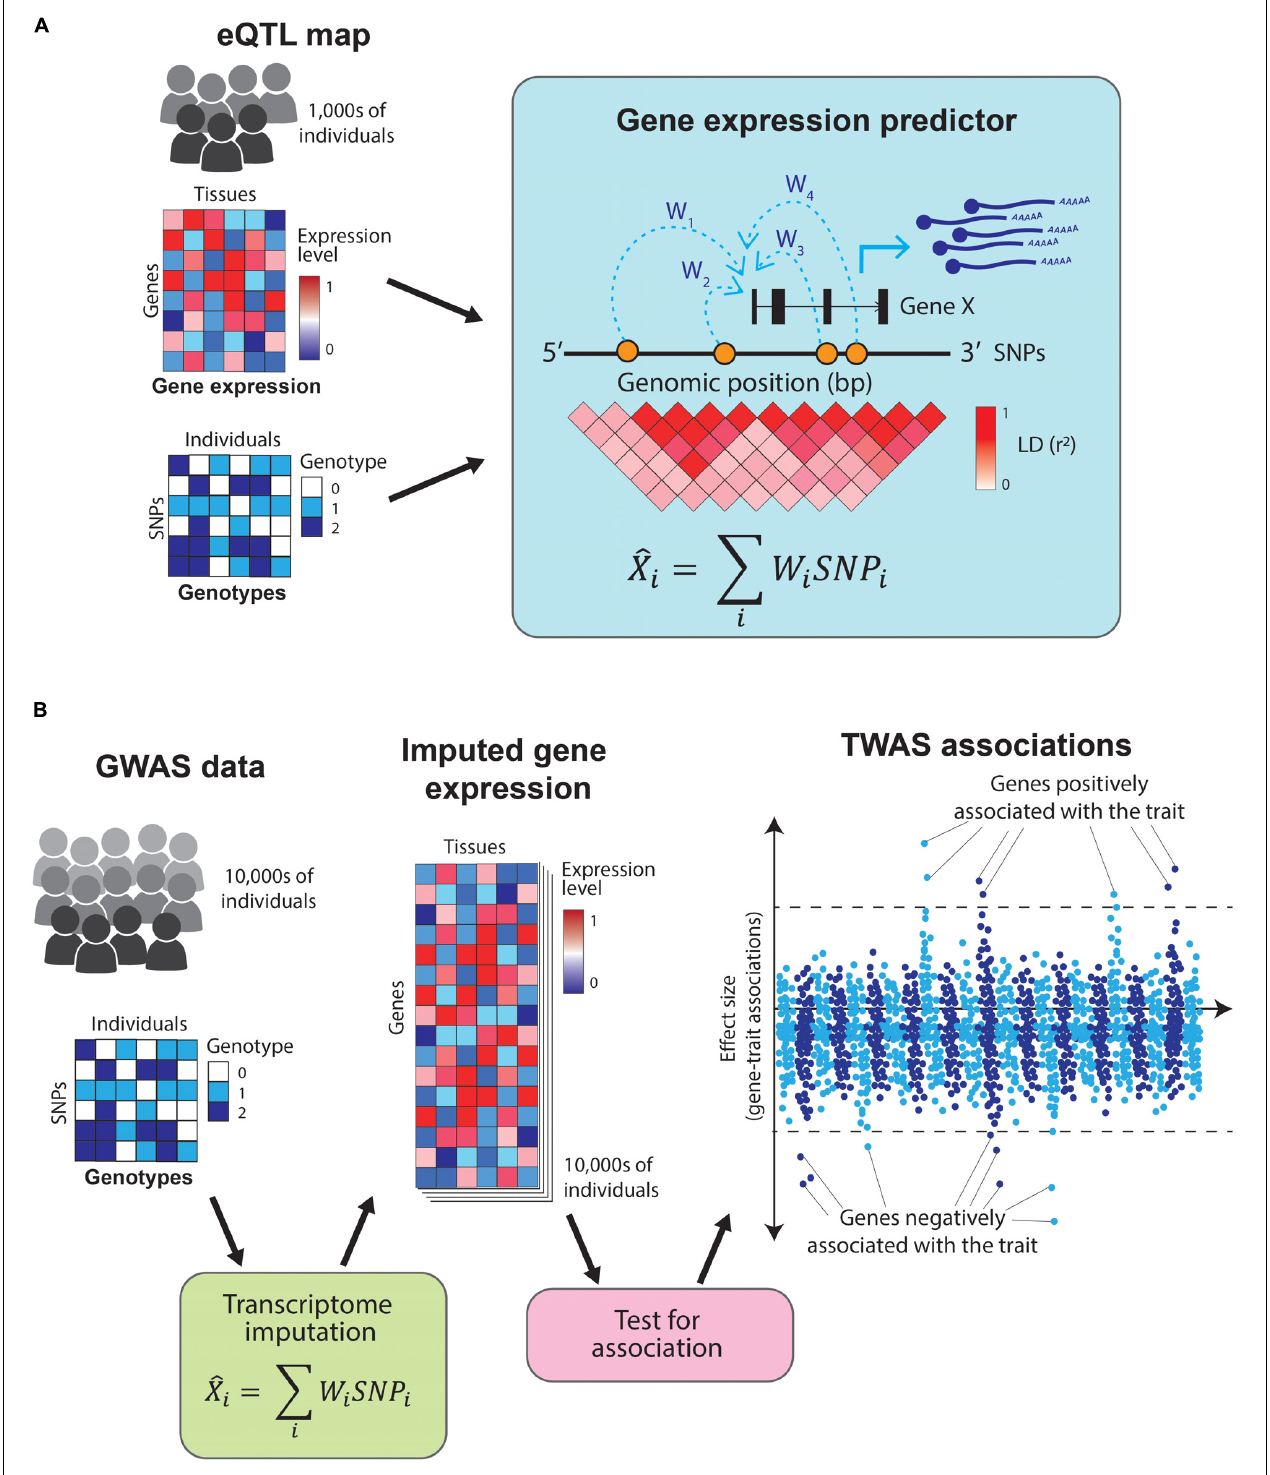
FIGURE 4 | Overview of transcriptome-wide association studies TWAS leverage information from eQTL catalogs and GWAS studies to directly associate traits to genes. (A) TWAS use eQTL maps (which contain tissue-specific gene expression and genotypes for thousands of individuals) as a training set to build gene expression predictors. These predictors take the SNPs in cis to a gene and estimate its expression levels. (B) The resulting predictors are used to impute gene expression values across the hundreds of thousands of individuals in a GWAS study (which contains genotypes but no gene expression data). Finally, the imputed gene expression values are directly tested for association with the GWAS trait, resulting in a set of genes which positively or negatively influence it.